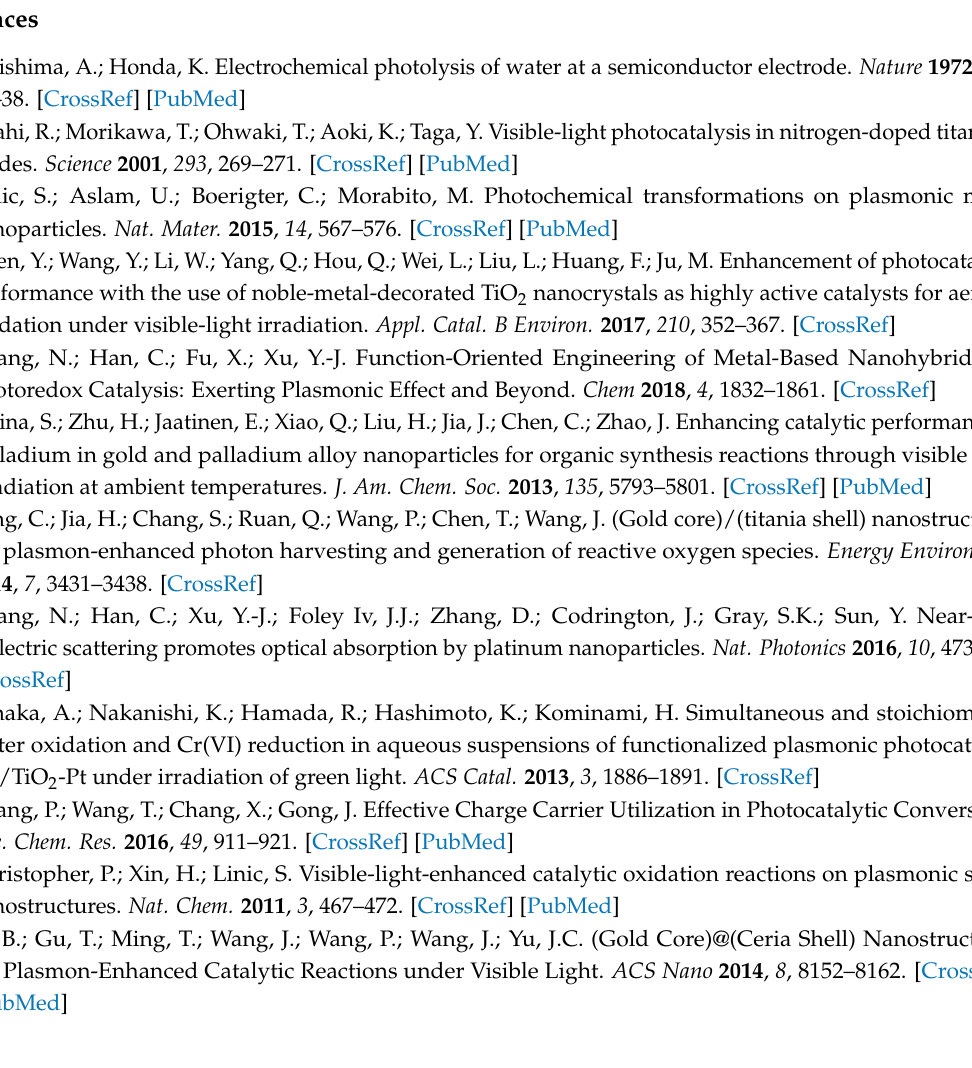
Figure S1: TEM images of Au 2 Pt 2 /N–TiO 2 photocatalyst; Figure S2: (a) N 2 adsorption/desorption isotherm of as-prepared catalysts; (b) the corresponding Barrett–Joyner–Halenda (BJH) desorption pore size distribution; Figure S3: Fine XP spectra of (a) Au 4f , (b) Pt 4f , (c) N 1s , and (d) O 1s obtained from Au 2 Pt 2 /N-TiO 2 ; Figure S4: (a–d) Diffuse-reflectance UV–Vis spectra of TiO 2 , N-TiO 2 , Au 2 Pt 2 /TiO 2 , and Au 2 Pt 2 /N-TiO 2 catalysts and the quantum yield for the formation of benzaldehyde under laser irradiation of different wavelengths, such as 405 nm, 450 nm, 500 nm, 532 nm, and 635 nm. The apparent quantum yield was calculated using the equation Φ − Y × 100%, where Y AQY = ( Y vis dark )/ N vis and Y dark denote the yield of benzaldehyde under light and dark conditions, respectively. N denotes the number of incident photons in the reaction vessel; Figure S5: Recyclability tests of Au 2 Pt 2 /N–TiO 2 for the selective oxidation of benzyl alcohol; Figure S6: (a,b) TEM images of Au 2 Pt 2 /N–TiO 2 catalyst after photocatalysis reaction; (c,d) the EDX analysis of photocatalysis before and after photocatalysis reaction; Table S1: Summarized physical and chemical data for TiO 2 , N–TiO 2 , Au 2 Pt 2 /TiO 2 , and Au 2 Pt 2 /N–TiO 2